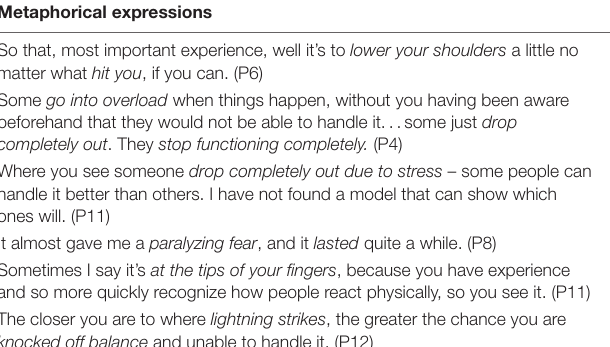
TABLE 8 | Quotes from experts illustrating metaphorical expressions of emotions. Metaphorical